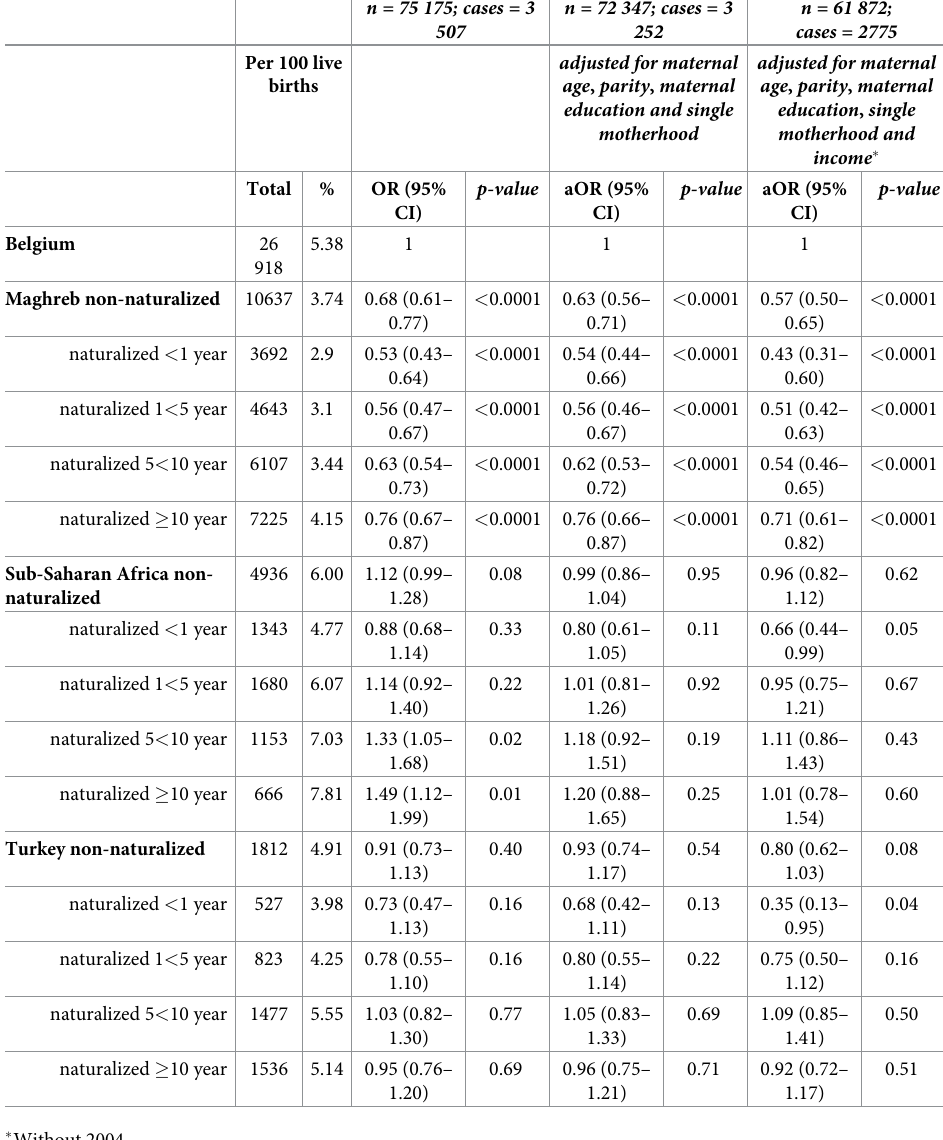
Table 3. Low birth weight (odds ratio and crude rates) according to naturalization